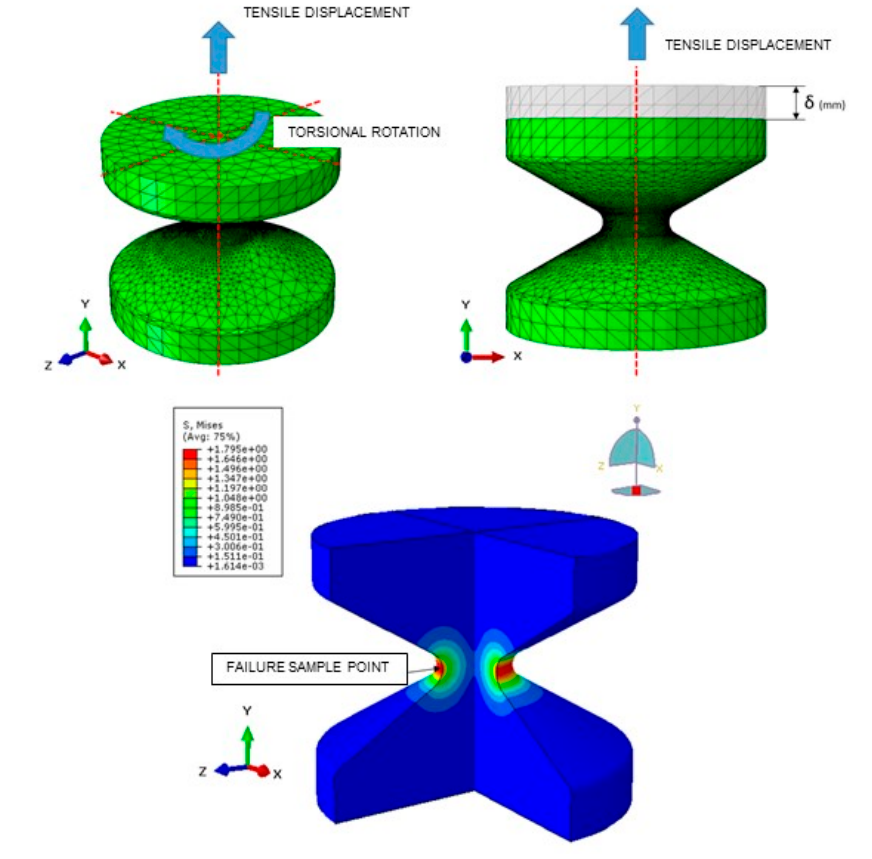
Figure 7. FEM model for test simulations.